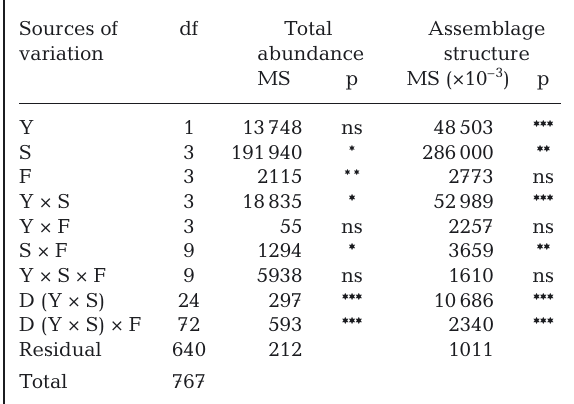
Table 1. PERMANOVA results for total abundance of wild fish and assemblage structure around the fish farm. Y: